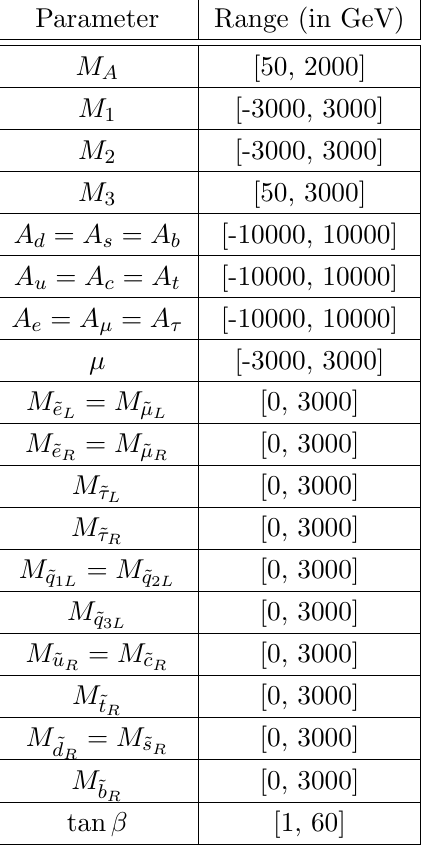
Table 3. The pMSSM19 parameter ranges used in our